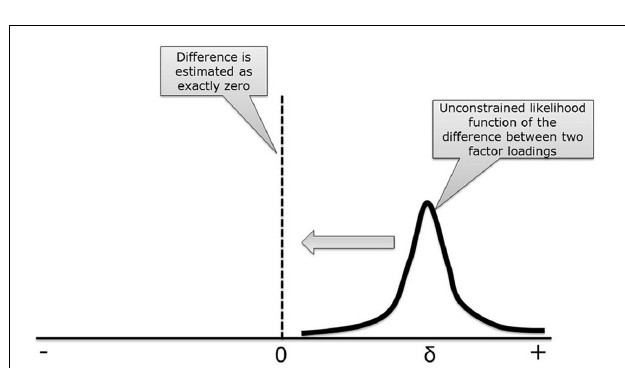
FIGURE 2 | The influence of applying MI while the difference between factor loading is clearly not zero.